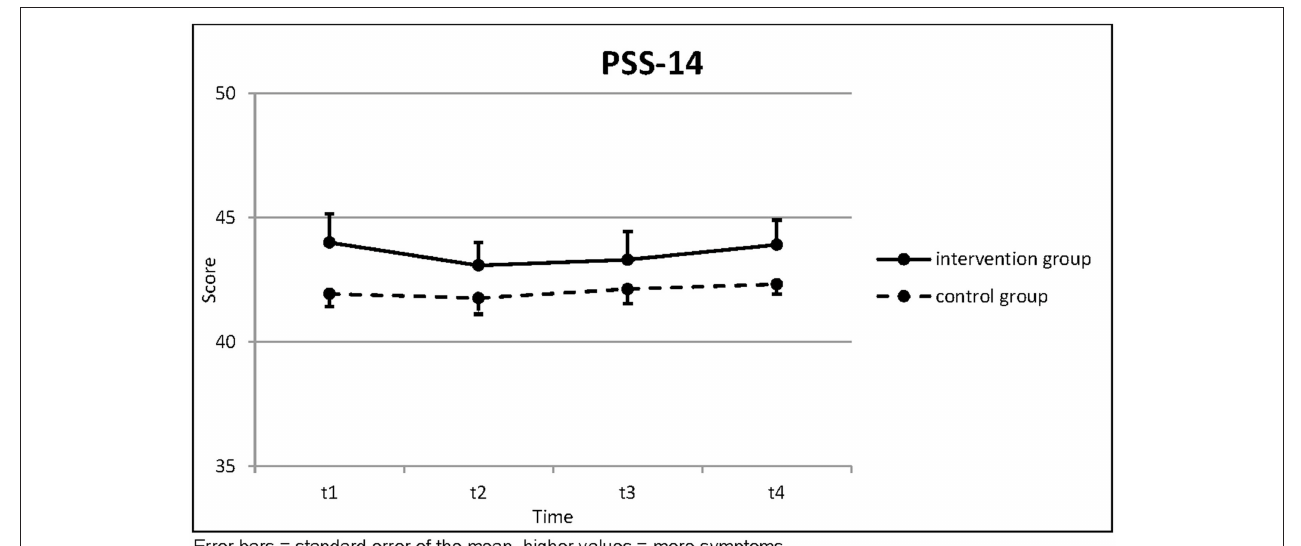
FIGURE 2 | Perceived Stress Scale